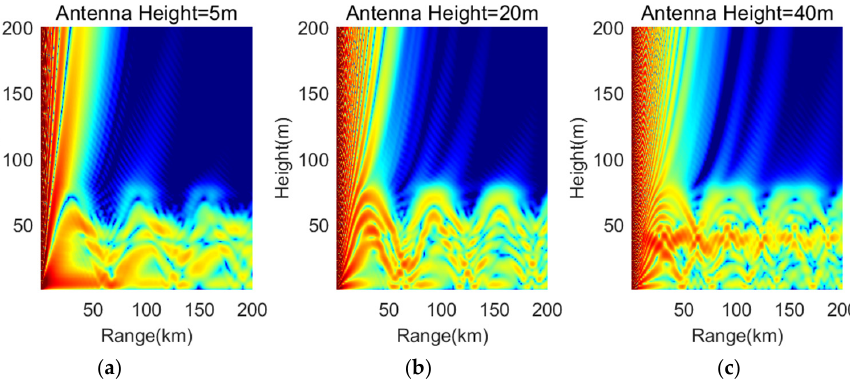
Figure 18. Path loss distributions for hybrid ducts with di ff erent antenna heights: ( a ) antenna height of 1 m, ( b ) antenna height of 20 m, and ( c ) antenna height of 40 m.